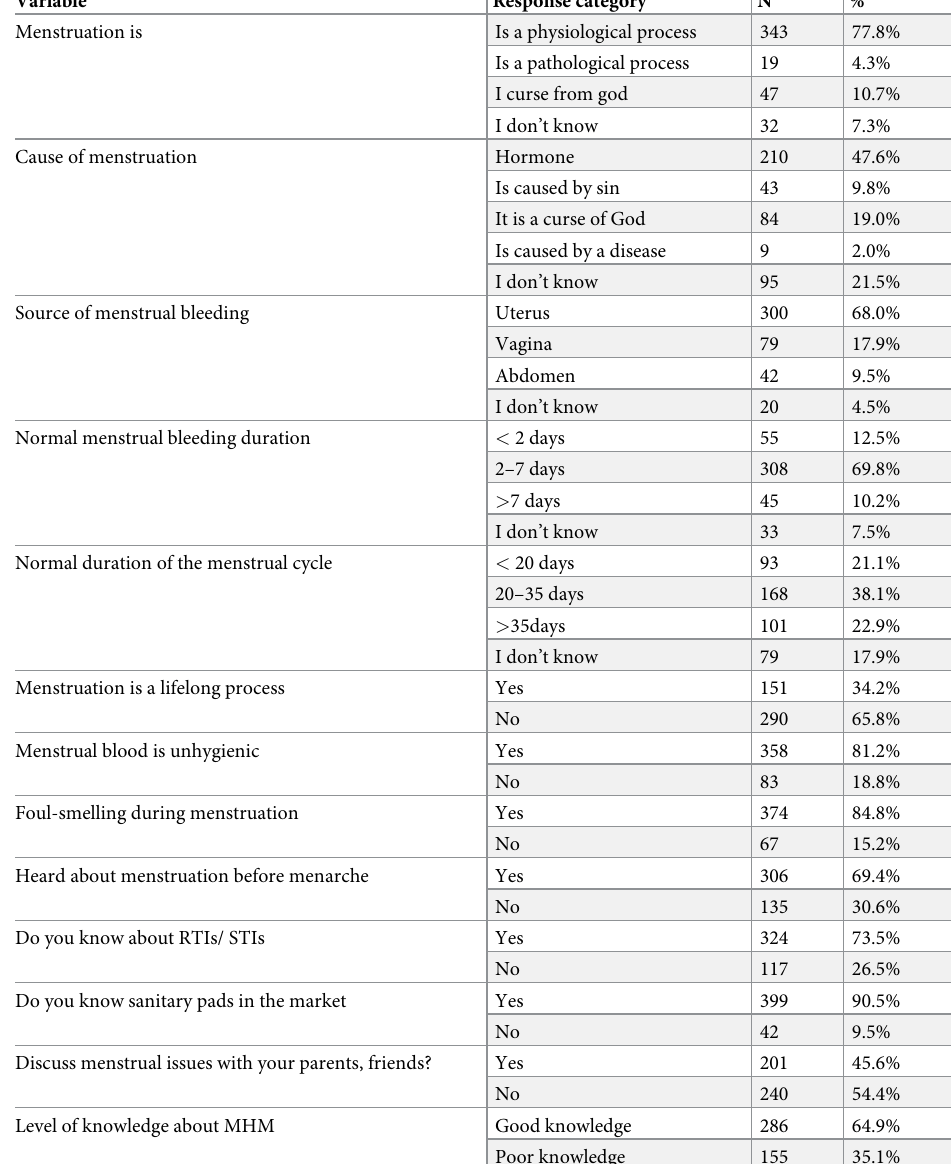
Table 2. Respondents Overall Knowledge about menstrual hygiene management in Mekdela secondary school, Amhara regional state, Northeast Ethiopia, 2020 (n = 441). Variable Response